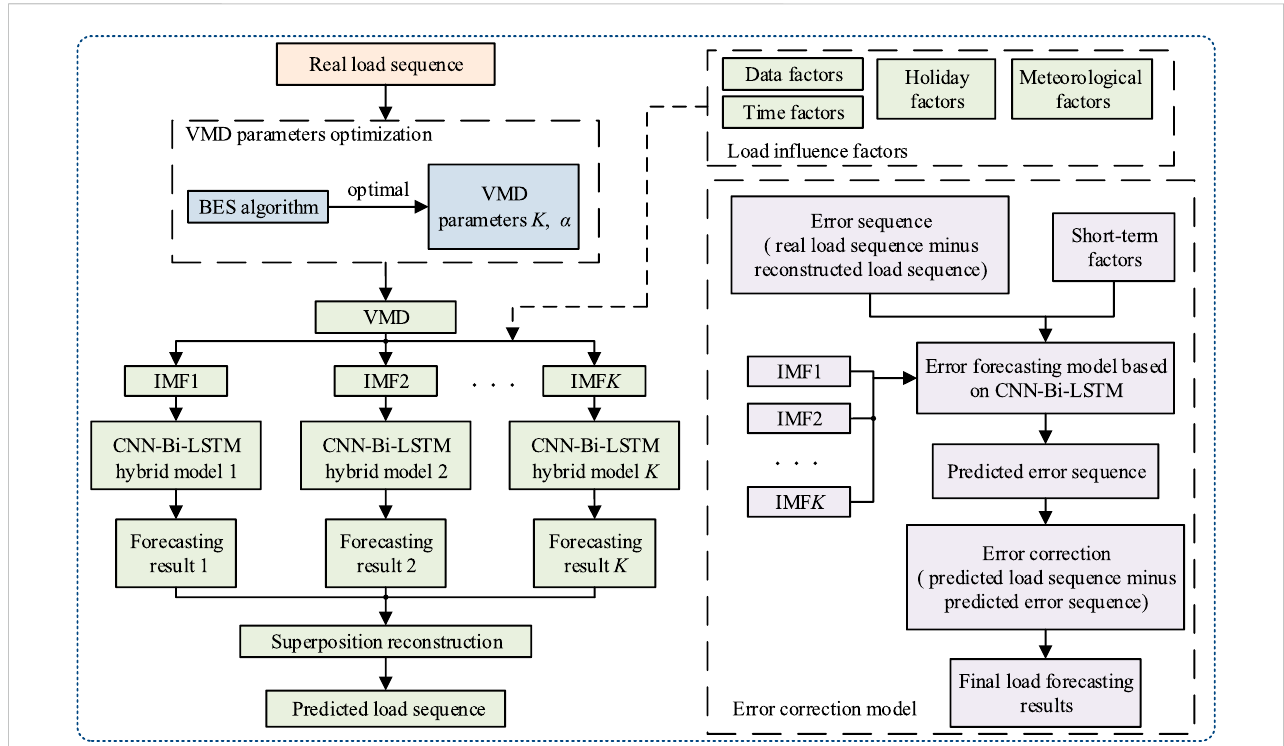
FIGURE 5 Short term load forecasting model via